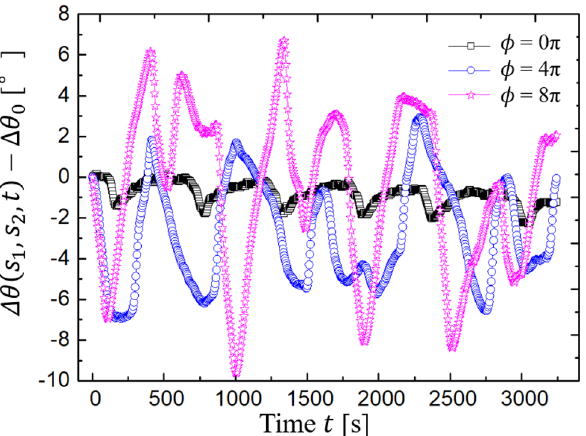
Figure 6. Angular variation �θ( s 1 , s 2 , t ) − �θ 0 of PDMS rotators driven by the BZ gels when the gels are pre- twisted for φ = 0 π , 4 π , and8 π (one realization).